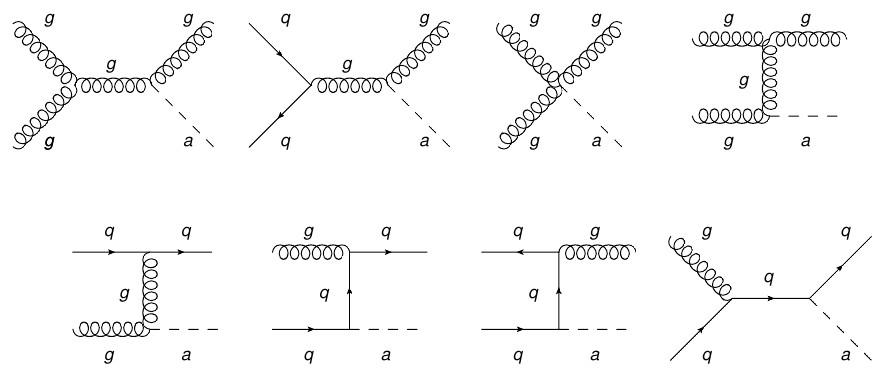
Figure 20: Feynman diagrams for DM production with a monojet in the ALP frame- work.